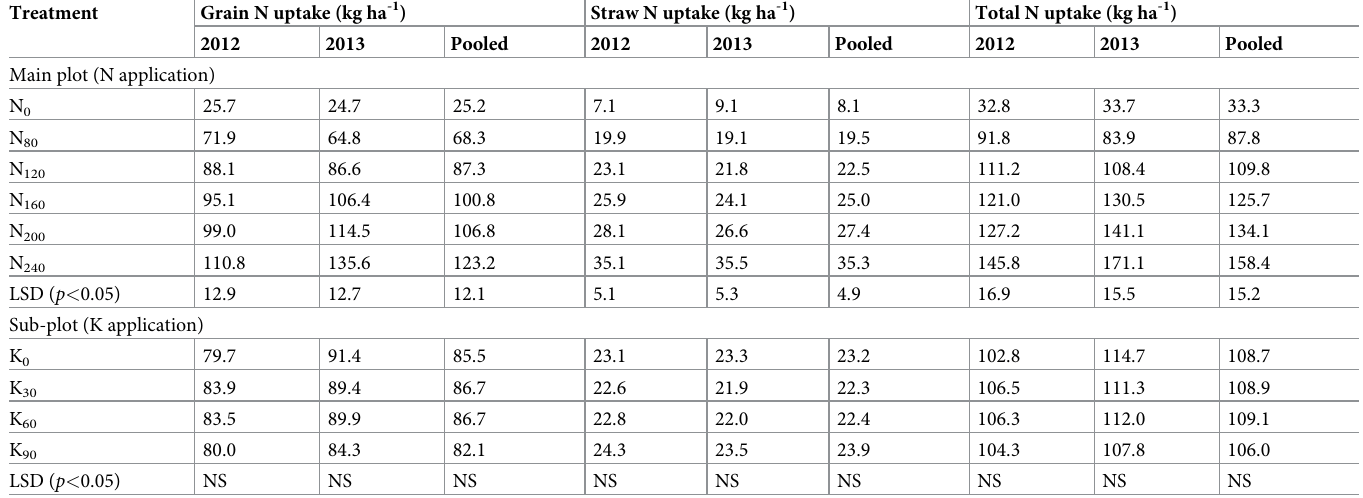
Table 3. Effect of nitrogen (N) and potassium (K) application on N uptake by grain and straw of wheat ( Triticum aestivum L.) in a sandy loam soil in sub-tropical India. Treatment Grain N uptake (kg ha -1